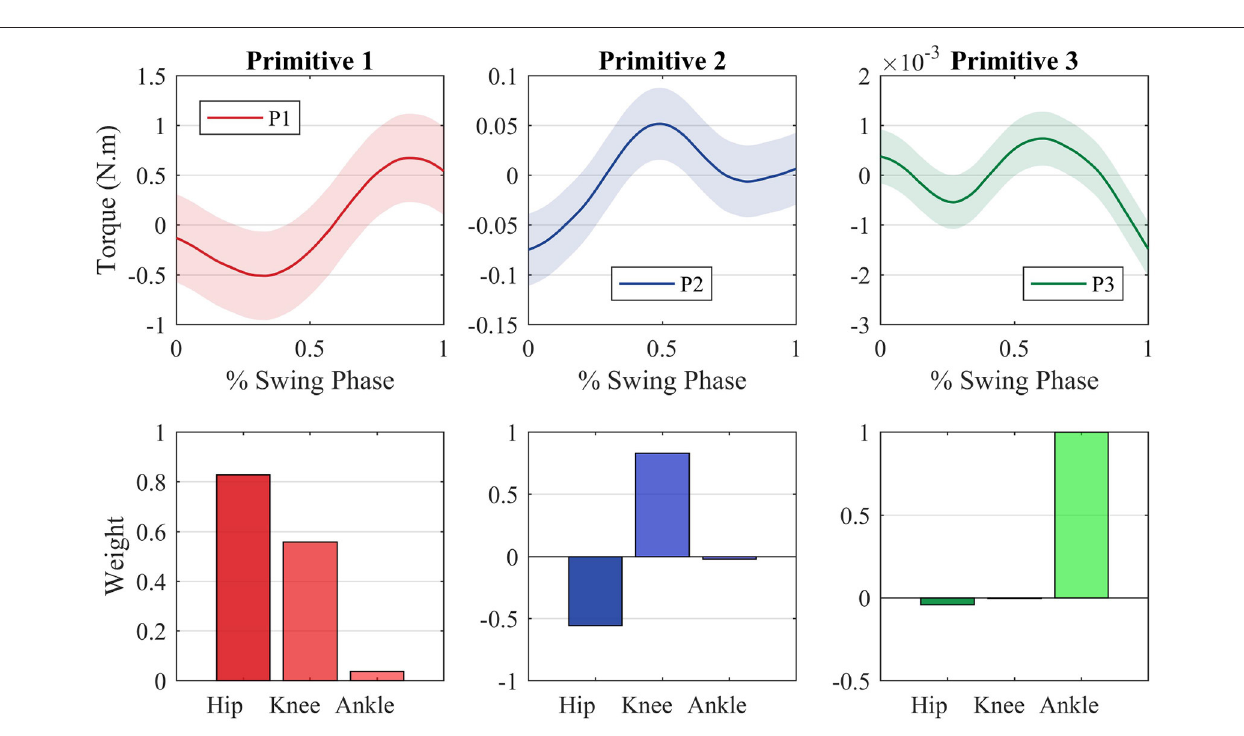
τ h , max = 25.8798